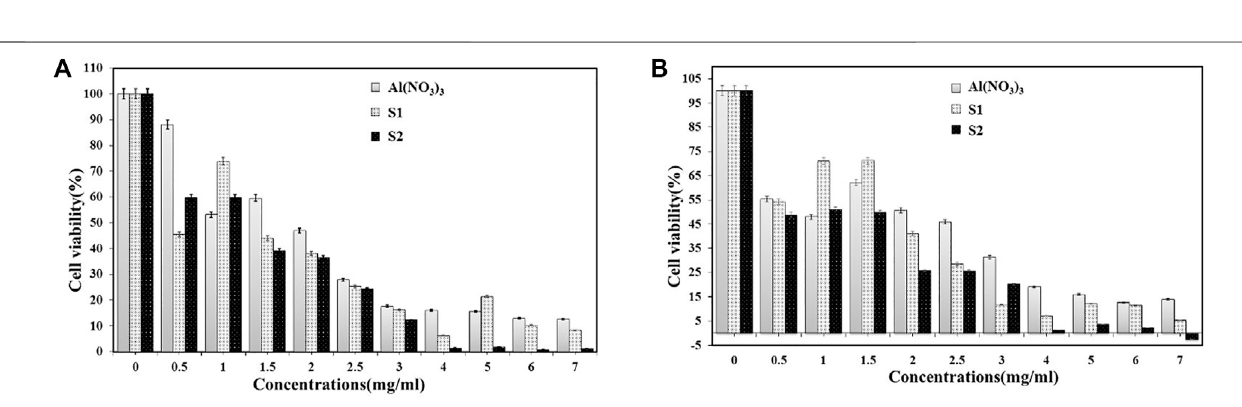
FIGURE 7 | The pore size distribution of (A) S1 and (B) S2 samples with BJH method.